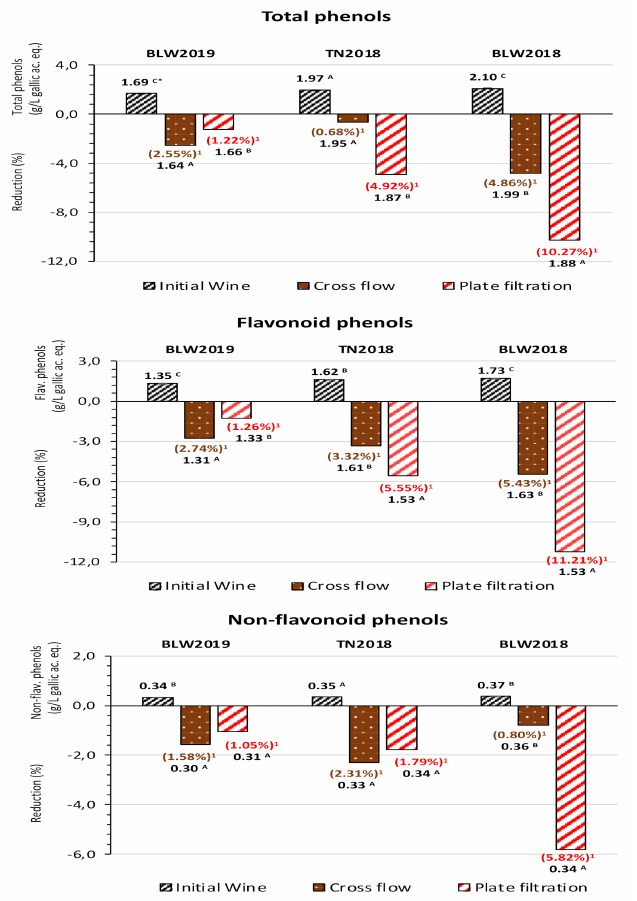
Figure 2. The impact of the two different filtration techniques on the total phenols, flavonoid and non- flavonoid phenols variation values for the three red wines studied. TN2018, the red wine produced from the Touriga Nacional grape variety in 2018; BLW2018, the red wine produced from a blend containing Touriga Nacional, Tinta Roriz, Alfrocheiro and Jaen grape varieties in 2018; BLW2019, the red wine produced from a blend containing Baga and Tinta Pinheira grape varieties in 2019. 1 The percentage of reduction in relation to the unfiltered wine. * The average values with the same letter and for the same red wine are not significantly different (Tukey test, p <